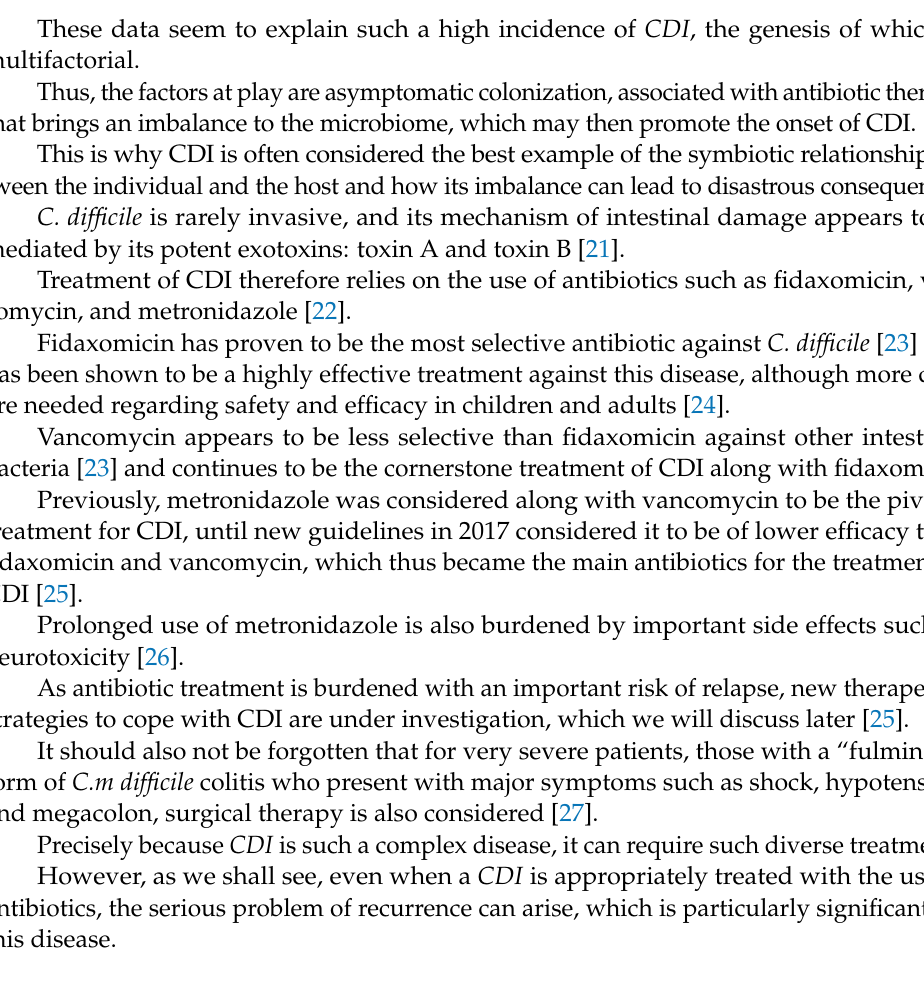
Figure 2. Pathogenesis of Clostridium difficile infection (CDI). One of the most accepted theories to explain the onset of CDI is the administration of antibiotics in a healthy C. difficile carrier patient. Antibiotic treatment, by generating a dysbiosis in the gut microbiota, causes a loss of its defense function, leading to the onset of CDI.